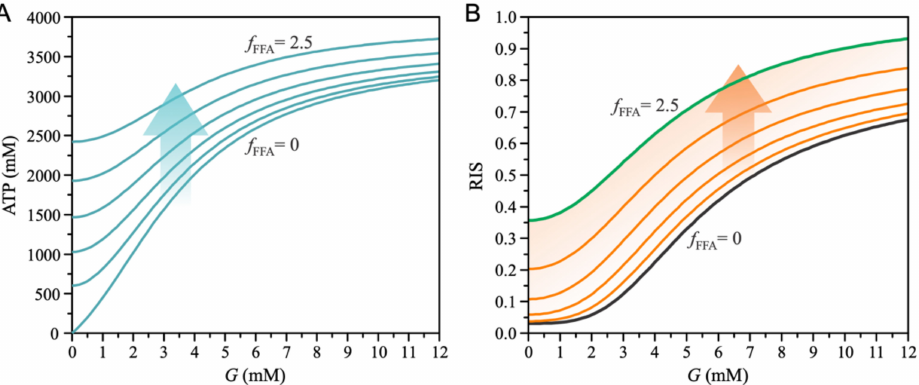
Figure 3. Effect of FFAs ( f FFA ) on ATP concentration near K ATP channels. The value of parameter f FFA increases from 0 to 2.5 with a step size of 0.5. ( A ) Glucose-dependent ATP concentration. Exposure to FFA increases basal ATP concentration, especially at low glucose levels, which consequently decreases glucose dependence. ( B ) Glucose-dependent relative insulin secretion (RIS). The FFA exposure increases basal RIS.